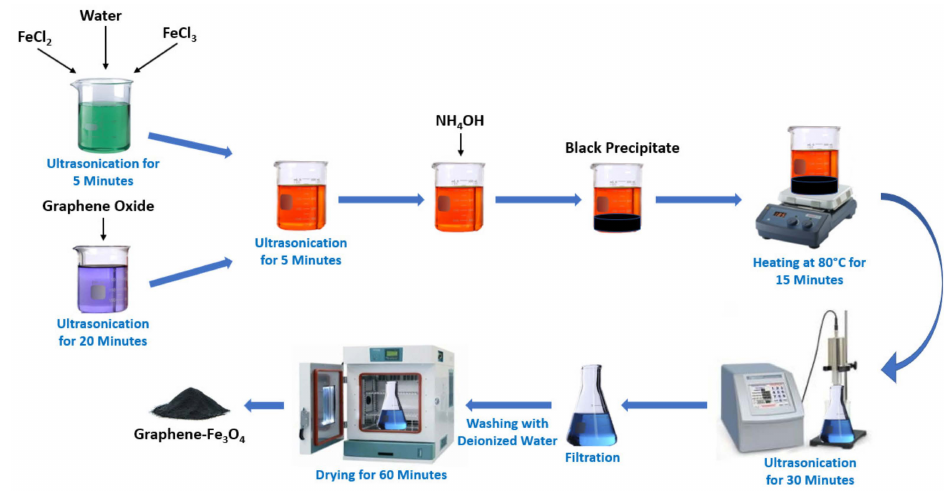
Figure 11. Schematic diagram of the rGO-Fe 2 O 3 nanocomposite. Adapted from [113]. The authors prepared nanofluids with diverse volume fractions between 0.01%